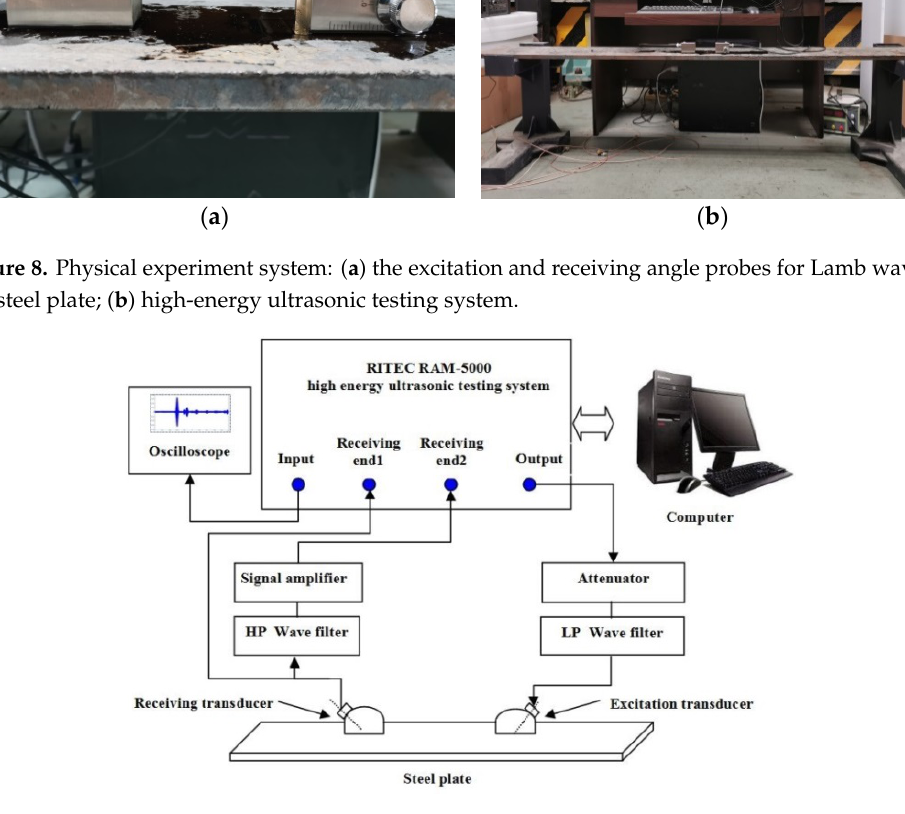
Figure 10. Signal diagram.